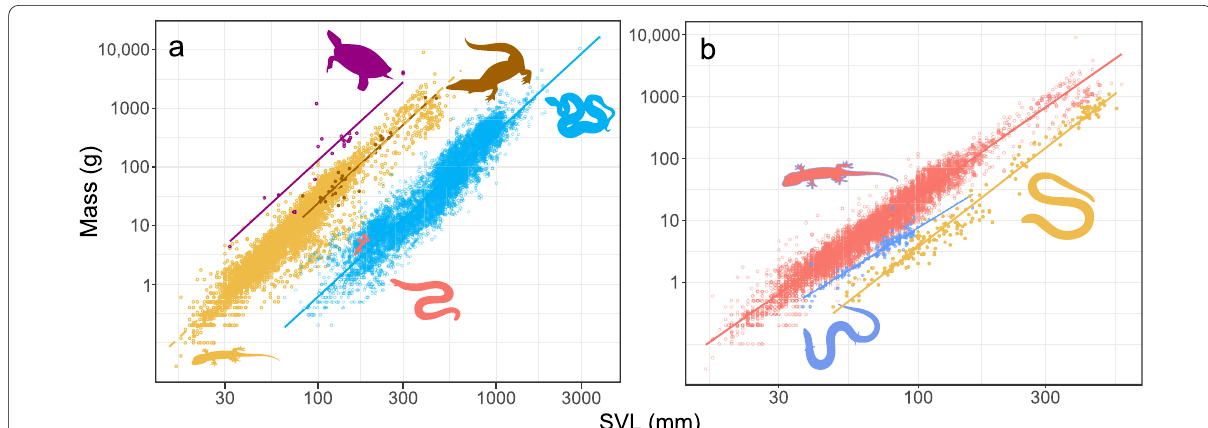
Fig. 1 The lengths and weights of specimens at the Steinhardt Museum of Natural History, Tel Aviv University a reptiles: 34 crocodiles (brown), 22 turtles (purple), 5110 snakes (blue), 7478 lizard (yellow) and 6 amphisbaenian (red) b only for lizards: colored according to leg development: fully developed (red), limb reduced (including two-limbed species; blue) and limbless species